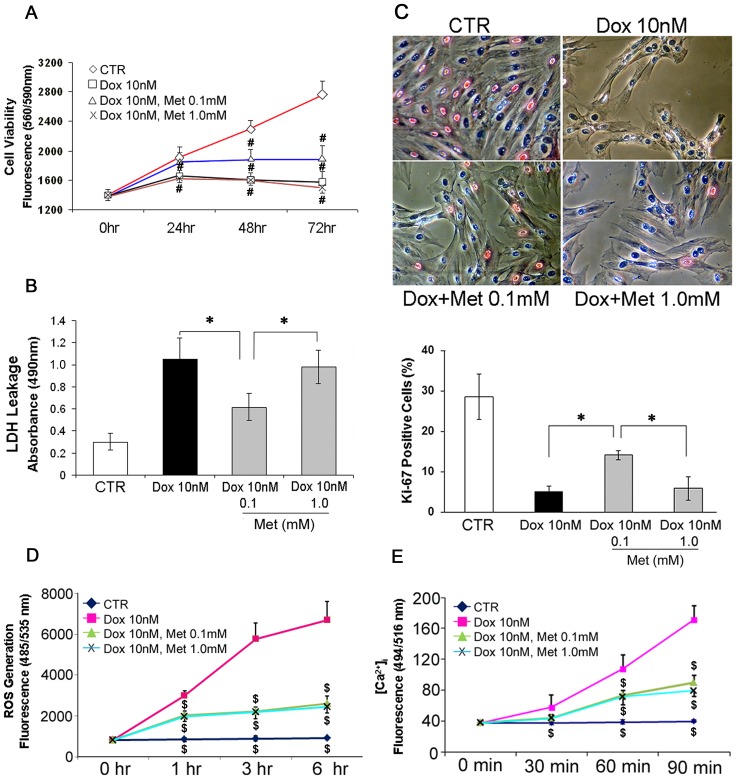
Low dose Met attenuates Dox induced cytotoxicity in H9c2 rat cardiomyoblasts.(A) H9c2 rat immortalized cardiomyoblasts were cultured with reduced FBS (1%) for up to 72 hours in 96-well culture plates under indicated conditions. Viability levels were estimated as described in Materials and Methods. (B) LDH leakages in H9c2 cells after Dox/Met treatment. Cells were treated with indicated conditions for 24 hours in serum free medium. LDH levels in culture supernatants were evaluated using LDH assay kit. (C) H9c2 cells were cultured on poly-L-lysine coated chamber slides for 24 hours under the conditions as indicated in reduced FBS medium. The slides were immunostained with anti-Ki-67 antibody (BD Biosciences) and ALP conjugated secondary antibody (Vector Laboratory). The numbers of Ki-67-positive vessels were counted in six randomized fields of the chambers. The total number of cells from each group was counted and normalized to each chamber. (D) H9c2 cells were cultured with conditions and for hours as indicated in serum free medium. Cellular ROS generations were measured using a detection assay kit. (E) H9c2 cells were cultured with serum free medium under the indicated conditions. Intra-cellular calcium levels ([Ca2+]i) were measured using fluo-4 (Molecular Probe), a fluorescent Ca2+-indicator dye. Values represent mean ± S.D. (n = 4) from quadruplicate samples for each treatment at varying treatment conditions. * p<0.05; # p<0.05 vs CTR; $ p<0.05 vs Dox 10 nM alone.